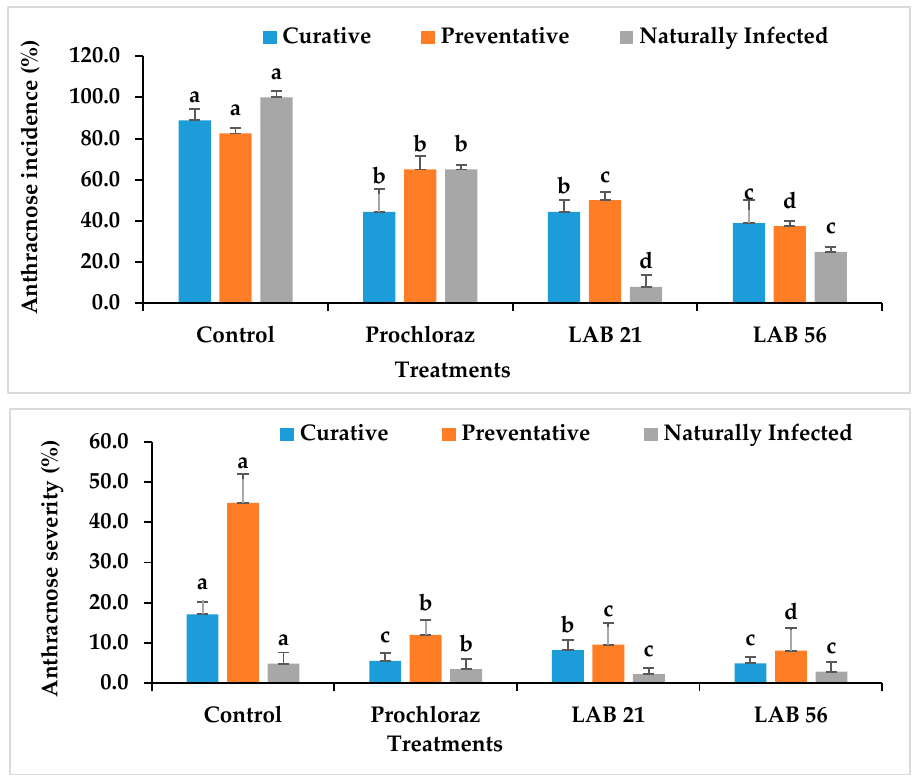
Figure 6. Effects of LAB strains on anthracnose disease incidence and severity in curatively, preventatively, and naturally infected fruit. Similar columns with different letters were significantly different at the p ≤ 0.05 level. Keys: control—sterile distilled water; Prochloraz ® (positive control); LAB 21— Weissella cibaria 21; LAB 56— Leuconostoc pseudomesenteroides 56.